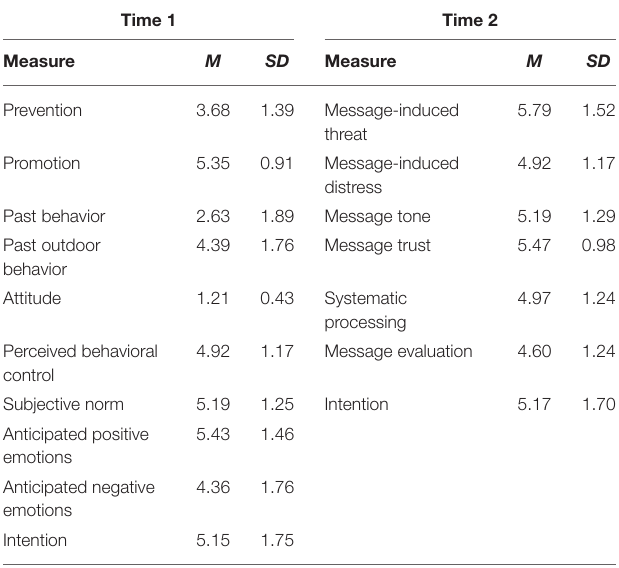
TABLE 1 | Means and standard deviations of the study measures. Time 1 Time